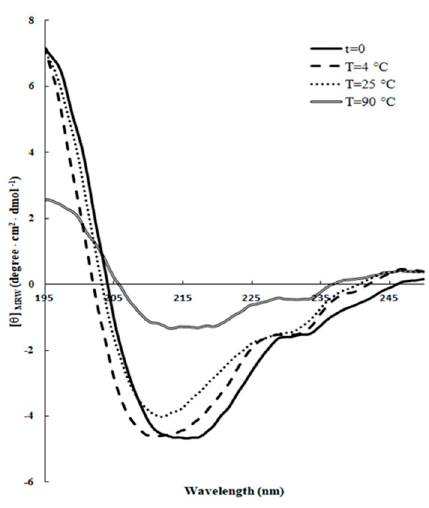
Table 3. Secondary structure contents of RiLK1 at different temperatures in the absence or presence of SDS (3 mM) determined by BeStSel and DichroWeb server.